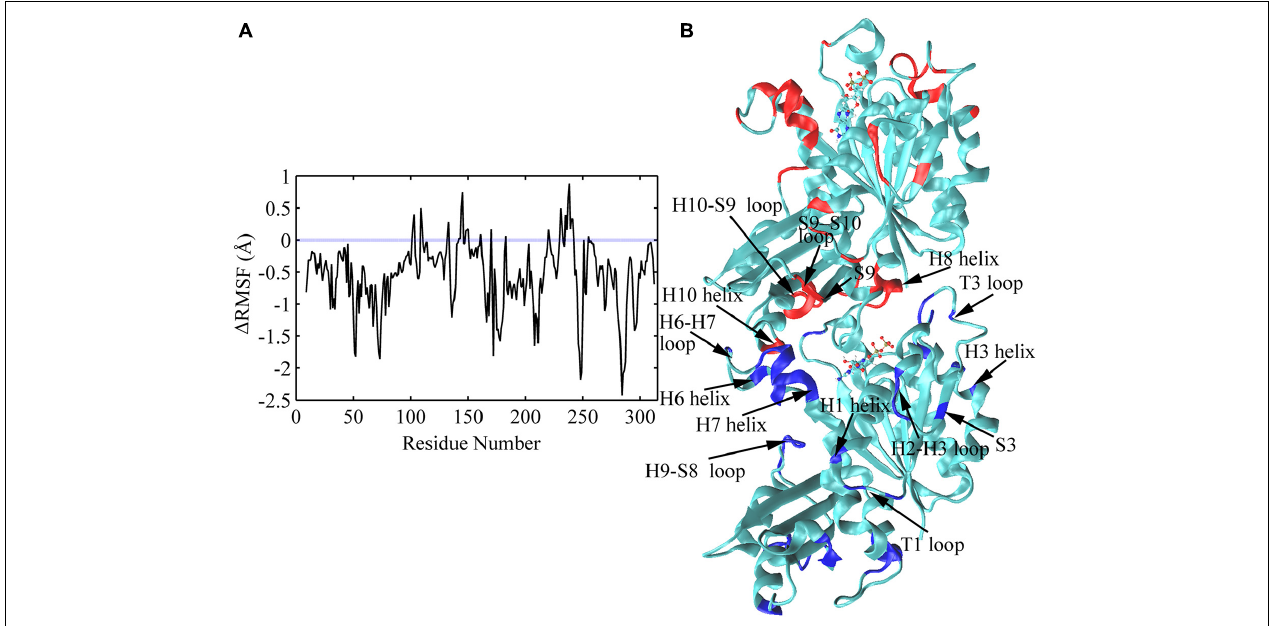
FIGURE 10 | Comparison of subunit RMSFs between GTP- and GDP-bound states. (A) Difference in RMSF values of each amino acid between GTP- and GDP-bound states averaged over the full trajectories. Positive values denote higher flexibility in the GTP-bound state, and negative values denote higher flexibility in the GDP-bound state. Amino acids exhibiting the largest nucleotide dependent differences in flexibility ( > 1.0 Å) were discussed in the main text, and highlighted with blue and red colors in panel (B) in a dimeric snapshot obtained from GDP-bound trajectories.